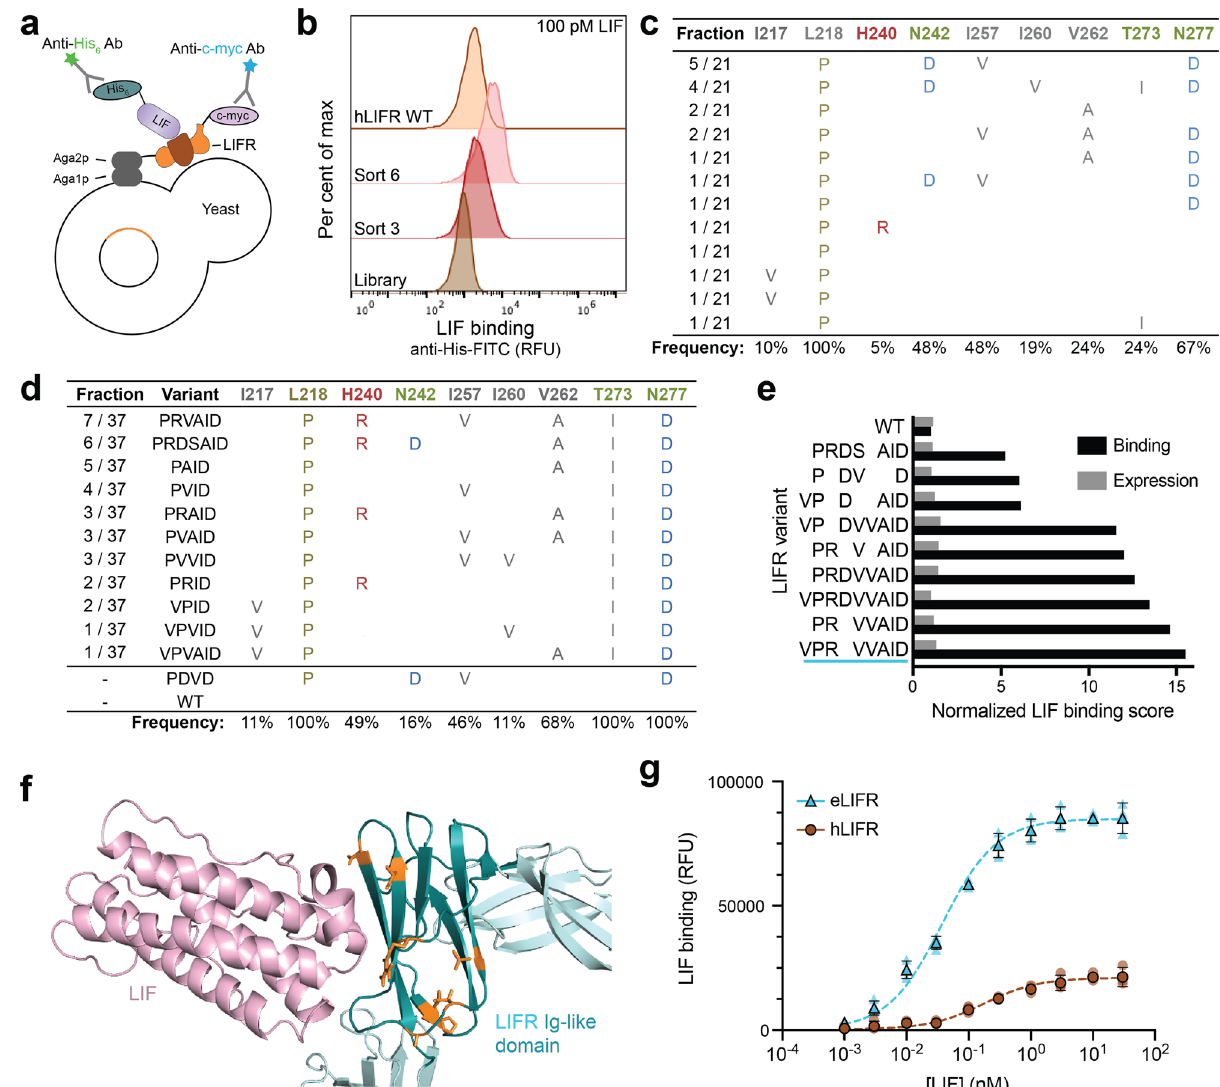
Fig. 2 Engineering and identi fi cation of LIFR variants with increased LIF-binding af fi nity. a Cartoon of detection of yeast-displayed LIFR expression and binding to His 6 -tagged LIF by fl ow cytometry. b LIFR binding at 100 pM LIF improved over successive rounds of library sorting. Flow cytometry histograms of the unsorted, fi rst-generation LIFR library ( “ Library ” ) and intermediate sorted populations (sort 3 and sort 6) compared to WT hLIFR. Only the gated population of yeast displaying LIFR are shown. The experiment was repeated at least three times independently with similar results. c Consensus mutations from Library 1, identi fi ed after six rounds of sorting. Amino acids with similar properties are grouped by color. d Unique sequences and consensus mutations from Library 2, sorts 4 and 5, listed in order of frequency. e LIF-binding scores of yeast-displayed WT and LIFR mutant variants, derived using site-directed mutagenesis, measured by fl ow cytometry. f Proposed structure of eLIFR in complex with LIF, modeled by inserting mutations into hLIFR WT PDB (3E0G) using Rosetta Remodel ( “ Methods ” ). hLIF was docked locally to the eLIFR model using RosettaDock. “ VPRVVAID ” mutations are shown in orange. g Yeast-displayed eLIFR (blue triangles) binds LIF-His with a higher af fi nity than WT hLIFR (brown circles). Higher maximum binding signal from eLIFR likely indicates a slower off-rate of binding. Binding curves were fi t using non-linear regression. Data are the geometric mean of fl uorescence of the expressing population ± standard deviation (SD) of triplicate measurements. Data from individual experiments are shown as faint